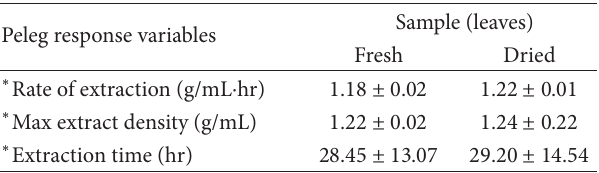
Table 2: Peleg’s maximum extract bulk density (g/mL) and exhaus- tive time (hr) of fresh and dried Clinacanthus nutans leaves water extract.